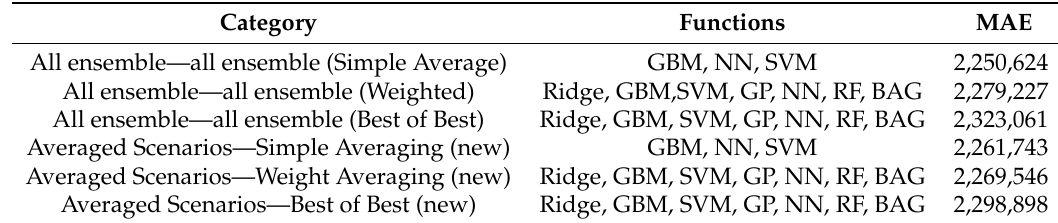
Table 6. The performances of ensemble methods with multiple forecasting machines are measured by the MAE in Wh/m 2